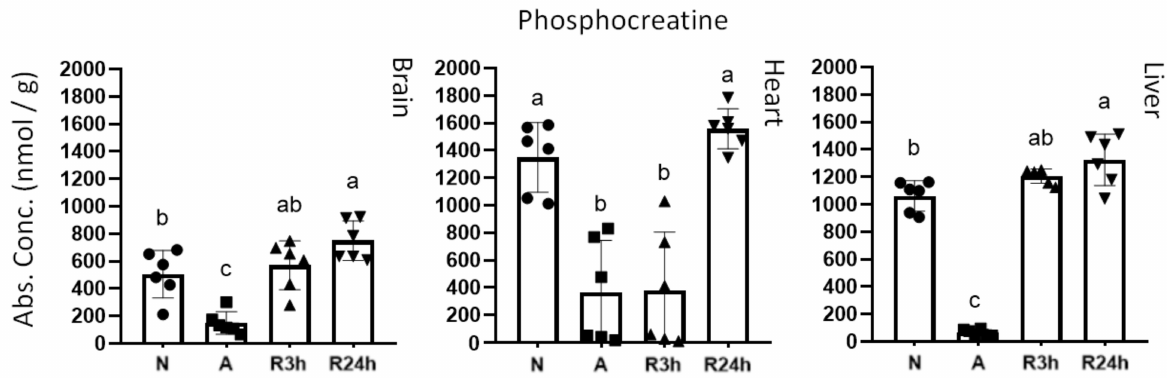
Figure 4. Phosphocreatine. Graphs of absolute concentrations for phosphocreatine of brain, heart, and liver. N, normoxia (control); A, anoxia; R3h, 3 h reoxygenation; R24h, 24 h reoxygenation. Different letters indicate statistical differences be- tween groups calculated using one-way ANOVA with Tukey’s post-hoc ( p -value ≤ 0.05). Data are presented as means ± S.D. Values as reported by